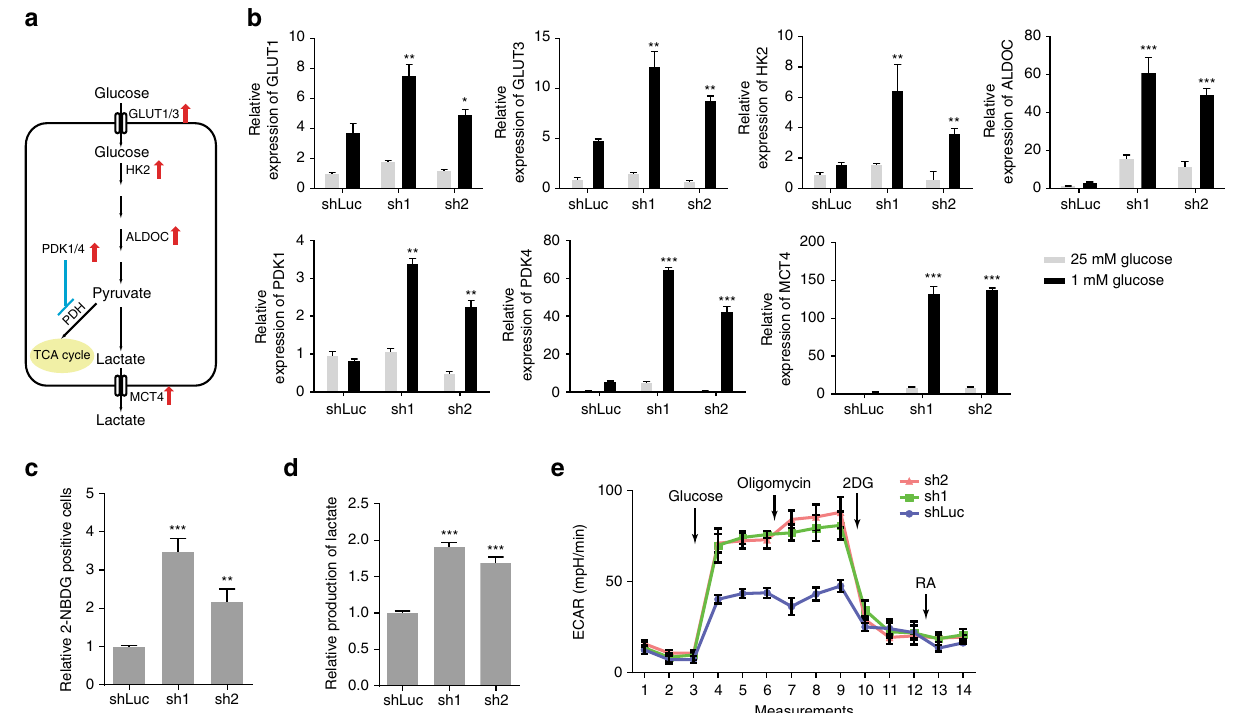
Fig. 3 FILNC1 de fi ciency leads to enhanced glucose uptake and lactate production. a The diagram shows the glycolysis pathway and highlights the genes involved in glucose metabolism which are induced by FILNC1 de fi ciency under glucose starvation. b – e 786-O cells infected with either control shRNA or FILNC1 shRNA were cultured in 1 mM glucose-containing medium for 24 h, and then subjected to various analyses to measure the expression levels of genes involved in glucose metabolism by real-time PCR ( b ), glucose uptake ( c ), lactate production ( d ), or extracellular acidi fi cation rate by Seahorse ( e ). Values represent mean ± s.d. from three independent experiments, two-tailed Student ’ s t -test. * P < 0.05; ** P < 0.01; *** P < development in vivo, which is consistent with our data showing the induction of FILNC1 by FoxO transcription factor, a tumor suppressor in renal cancer 19 (Fig. 1).